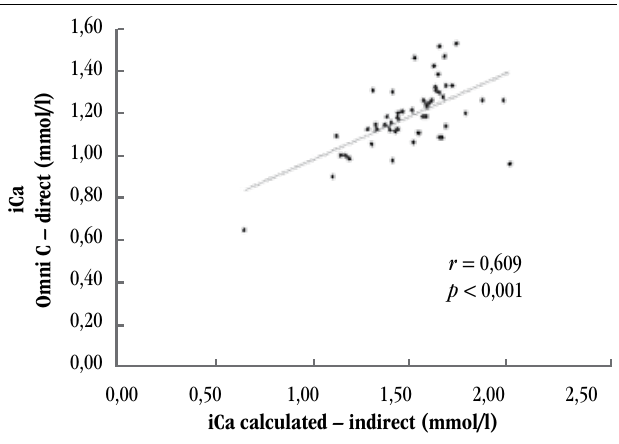
figurE – Pearson’s correlation between ionized calcium obtained by potentiotiometry (Omni C) and obtained by formulae